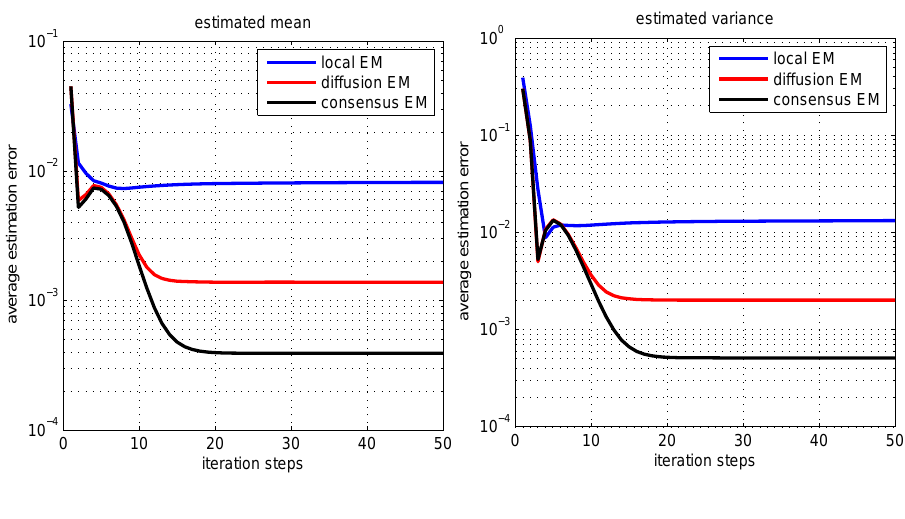
Figure 7. Performance comparison for different EM algorithms with 1,000 sensor